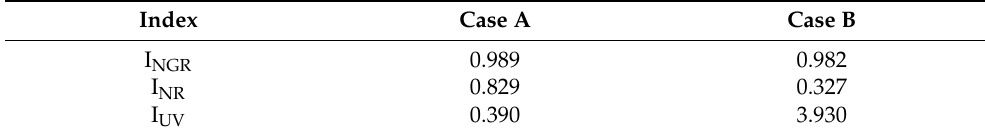
Table 4. Comparison of the proposed additional indexes in Case A and Case